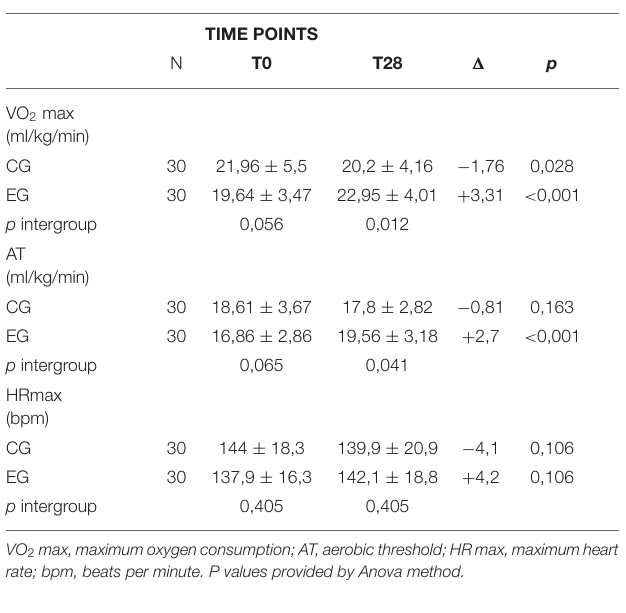
TABLE 2 | Assessment of the VO 2 max, AT e HR max variables in the EG and CG groups before and after 28 weeks.